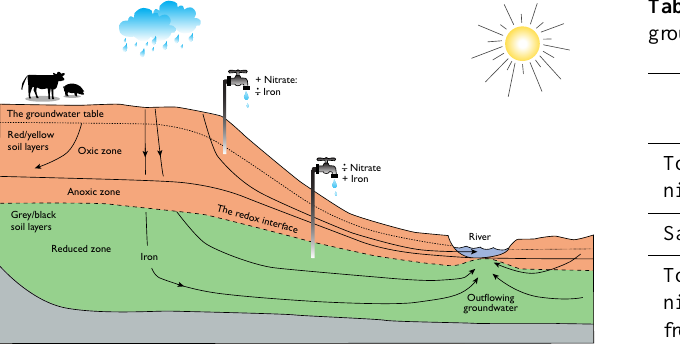
Fig. 1. Conceptual model of the typical groundwater redox envi- ronment in Denmark with oxic zone, anoxic zone with nitrate re- duction and reduced zone. The interface between the anoxic zone containing nitrate and the reduced nitrate-free zone is called the ni- trate interface and can also be determined based on the colours of the sediments. Above the nitrate interface, the soil layers have red and yellow colours, and below the nitrate interface the soil layers have grey and black colours.